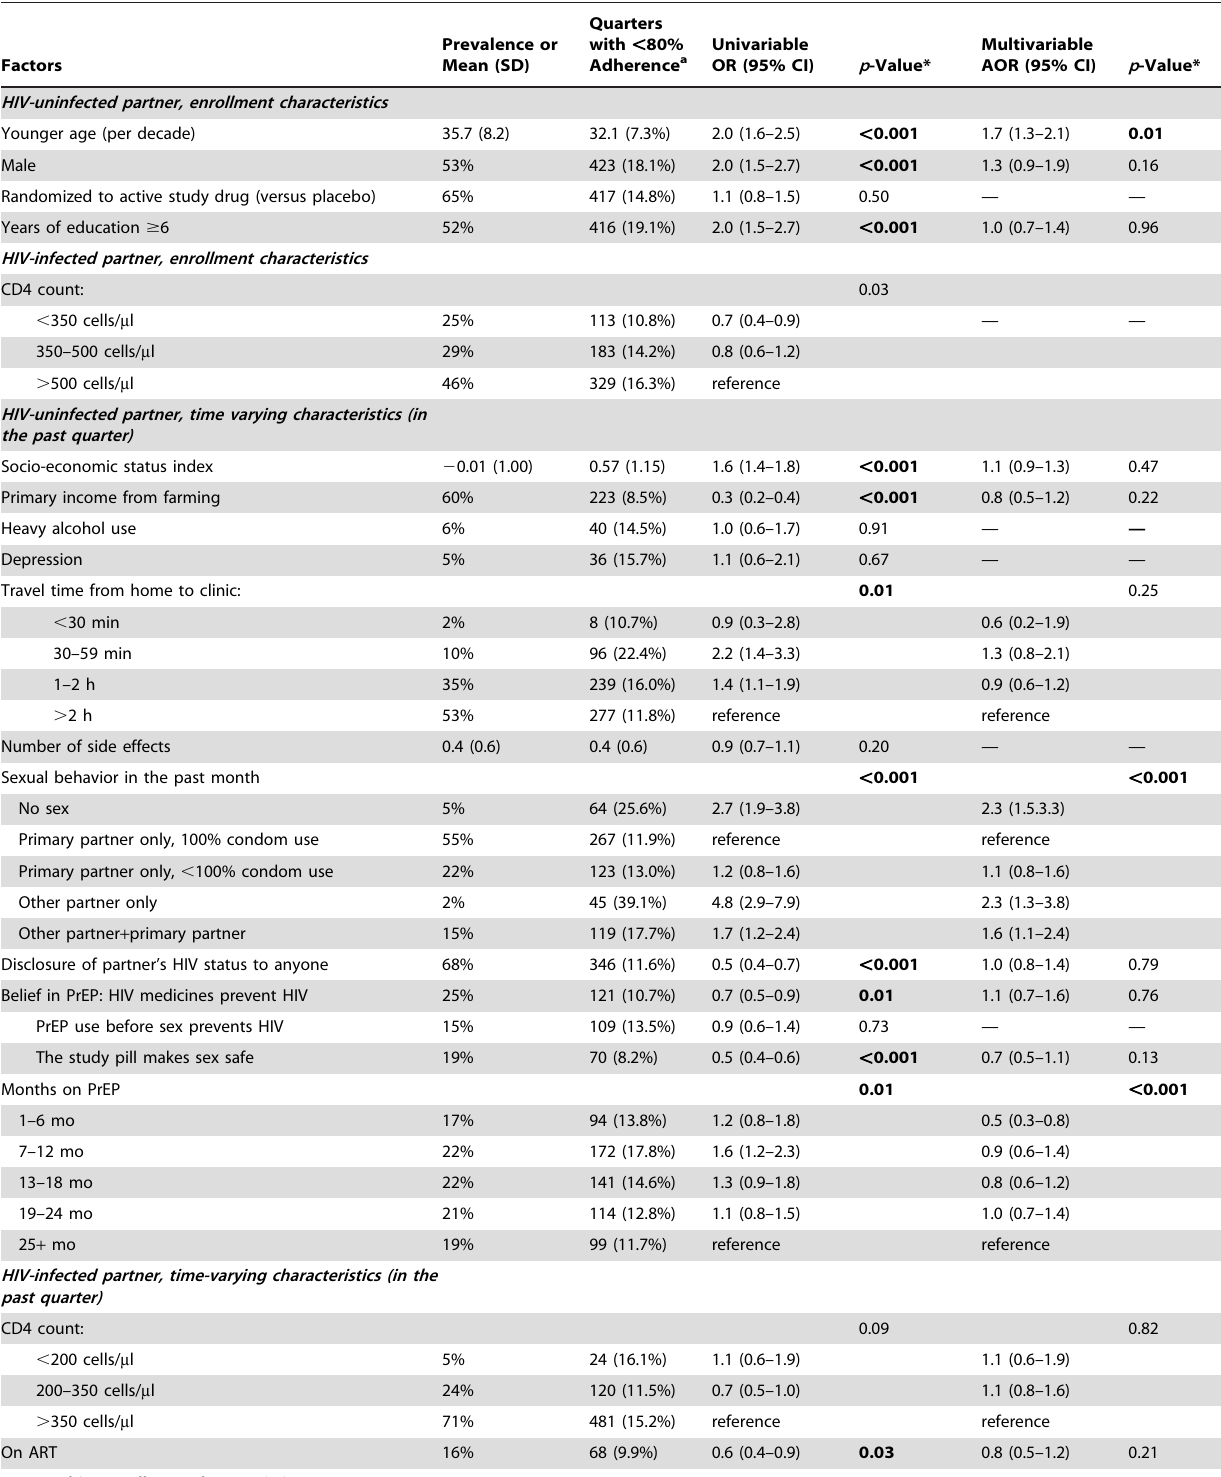
Table 4. Univariable and multivariable regressions of factors correlating with , 80% electronic monitoring